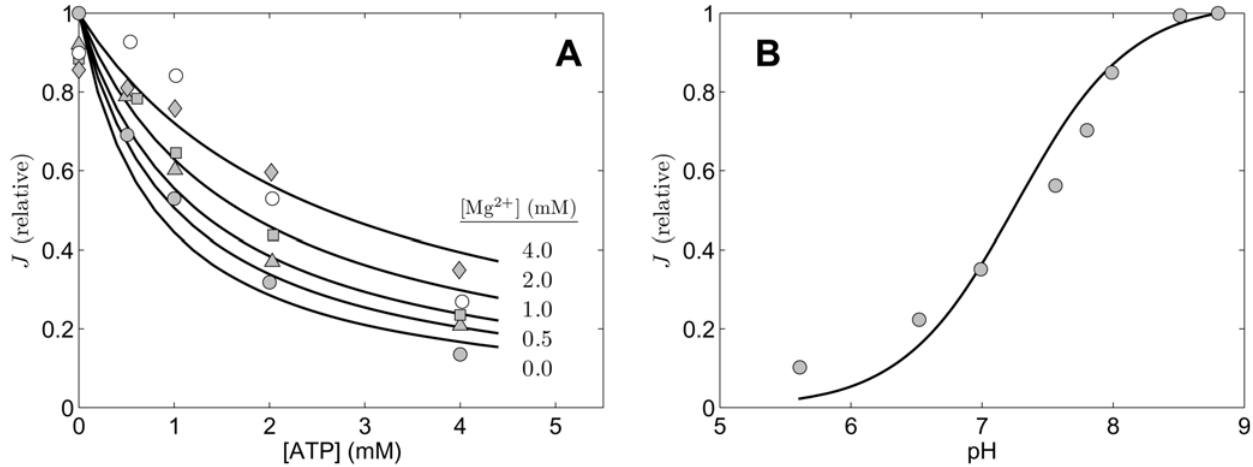
Figure 5. Impact of [Mg 2 + ] and pH on liver enzyme. Measured flux in arbitrary units was obtained from Figures 13 and 14 of [15]. A. The relative activity (normalized to its maximum) of the enzyme is plotted as functions of [ATP] at [Mg 2 + ]=0 mM (shaded circles), 0.5 mM (shaded triangles), 1.0 mM (shaded squares), 2.0 mM (open circles), and 4.0 mM (diamonds). B. Relative activity is plotted as a function of pH. Substrate concentations are [ACCOA]=21 m M and [OAA]=8.6 m M. All data were obtained at 25 u C. pH is fixed a 7.4 for A . Model fits are plotted as solid lines.